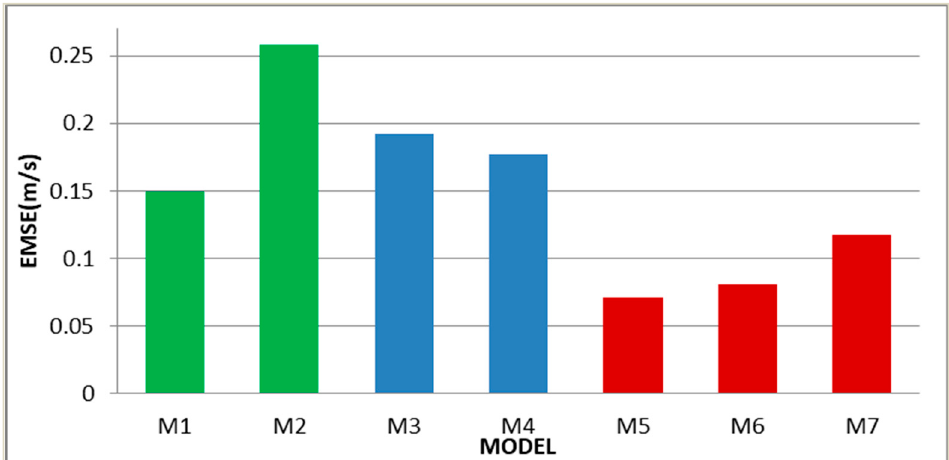
Figure 8. The comparison chart of root mean squared error (RMSE).